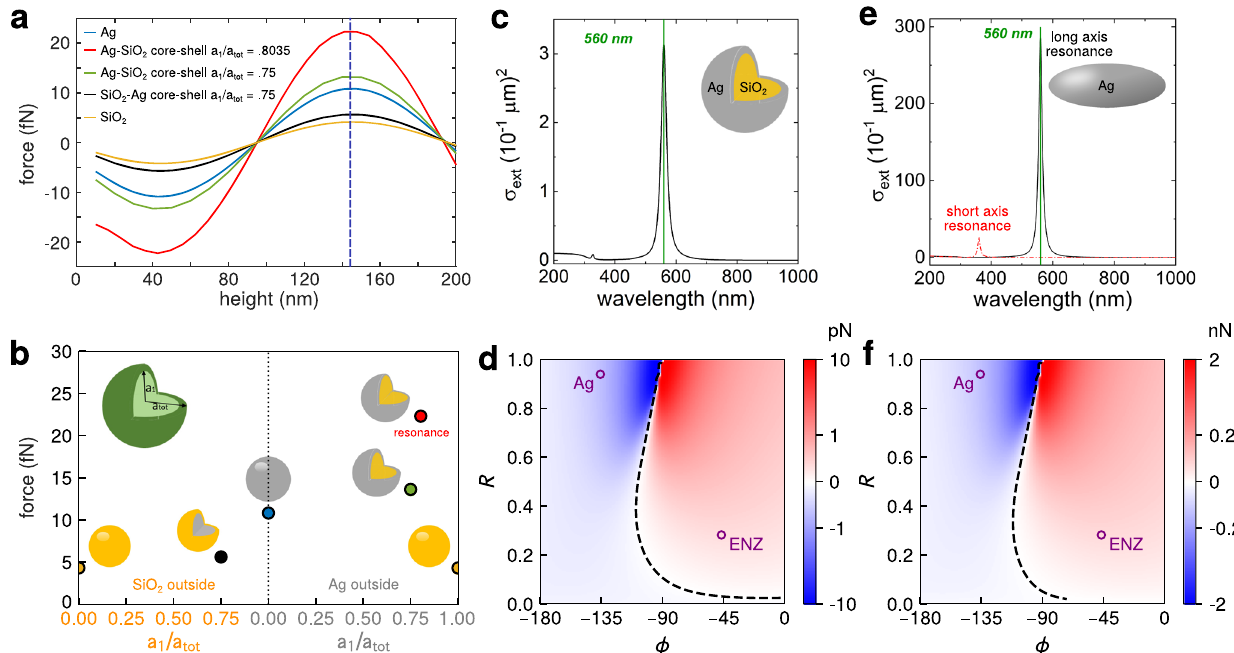
Fig. 4 Role of polarizability and shape on optical forces. a COMSOL calculation of total optical force on core – shell particles based on SiO 2 and Ag as a function of the distance from the metamaterial surface. Different ratios between core radius a 1 and total particle radius a tot = 20 nm have been considered. Moreover, both materials have been considered as a core. b Maximum force found in each core – shell structure considered, as pointed out by the dashed blue line in ( a ). c Extinction spectrum of the SiO 2 -Ag core – shell particle (total radius a tot = 20 nm and core radius a 1 = 16.1 nm) in water. d ( R , ϕ ) contour plot of the total optical force for the core – shell particle at h = 10 nm from the surface. The ENZ and Ag surfaces used for the calculation of the optical forces in DA approximation are shown as circles. e Extinction spectra of Ag prolate ellipsoid in water oriented with the long axis parallel to the fi eld (black solid line) and oriented with the short axis parallel to the fi eld (red dashed line). The resonances relative to the long and short axes are indicated. f ( R , ϕ ) contour plot of the total optical force on the Ag ellipsoid at h = 10 nm distance from the surface. In the calculation, the spheroid is aligned with the long axis in the direction of the wave polarization. The ENZ and Ag surfaces used for the calculation of the optical forces in DA approximation are shown as circles. The optical force is in the order of tens of pN in front of ENZ (repulsive) and Ag (attractive). The force can be close to 200 pN if the spheroid is in front of an ideal ENZ surface, having R = 1 and ϕ = Fig. 4e, the particle has, in water, a long axis resonance at 560 nm and a short axis resonance at 360 nm. For the calculation of the total optical forces we considered the case in which the spheroid has the long axis aligned with the wave polarization, and the short semiaxis as the size parameter in Eq. (1). We obtain a further enhancement of the total optical force (tens of piconewton, Fig. 4f) which, as in the core – shell structure, is repulsive in front of ENZ surface and attractive in front of Ag surface. In Fig. 4f, a contour plot of the total optical force, calculated as a function of the surface re fl ectivity R and phase shift ϕ , namely, in front of all possible surfaces, is shown. We clearly see that the repulsive force can be close to 200 pN in front of an “ ideal" ENZ surface, having the maximum re fl ectivity and a vanishing phase shift.